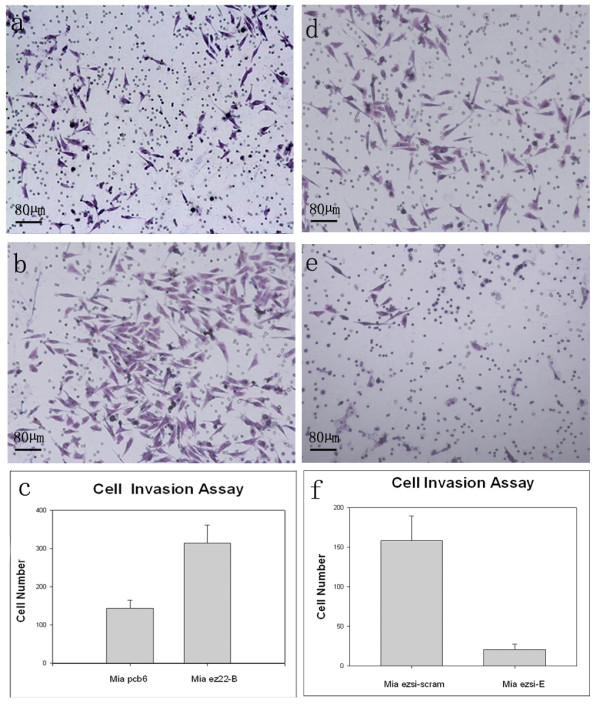
Effects of ezrin on cell invasion in vitro. Matrigel-coated transwell chambers were used to detect cell invasion and representative fields were photographed. Cell invasion of the Mia ez22 (b), Mia pcb6 (a), Mia ezsi-E (e) and Mia ezsi-cram (d) cells after 24 hours were shown. The cells invading to the lower chambers were analyzed. Compared to the Mia pcb6 cells, the Mia ez22-B cells showed a significant increase in invasion by x2-test (c). The decrease in the numbers of invasive cells in the Mia ezsi-E cells compared to those of the Mia ezsi-scram cells was statistically significant, shown by the x2-test (f). Columns: mean; bars: SD.